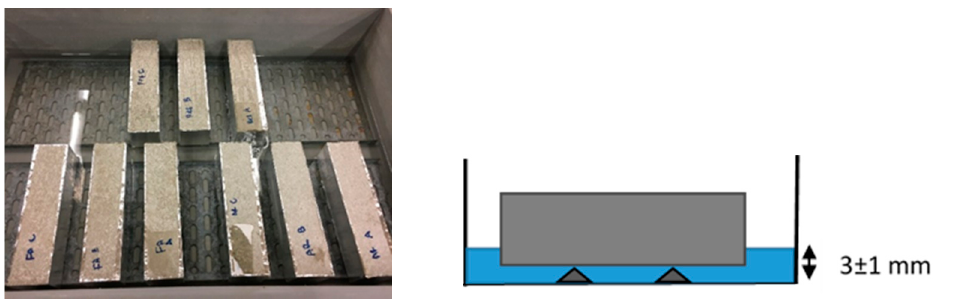
Figure 5. Capillary water uptake test set up.